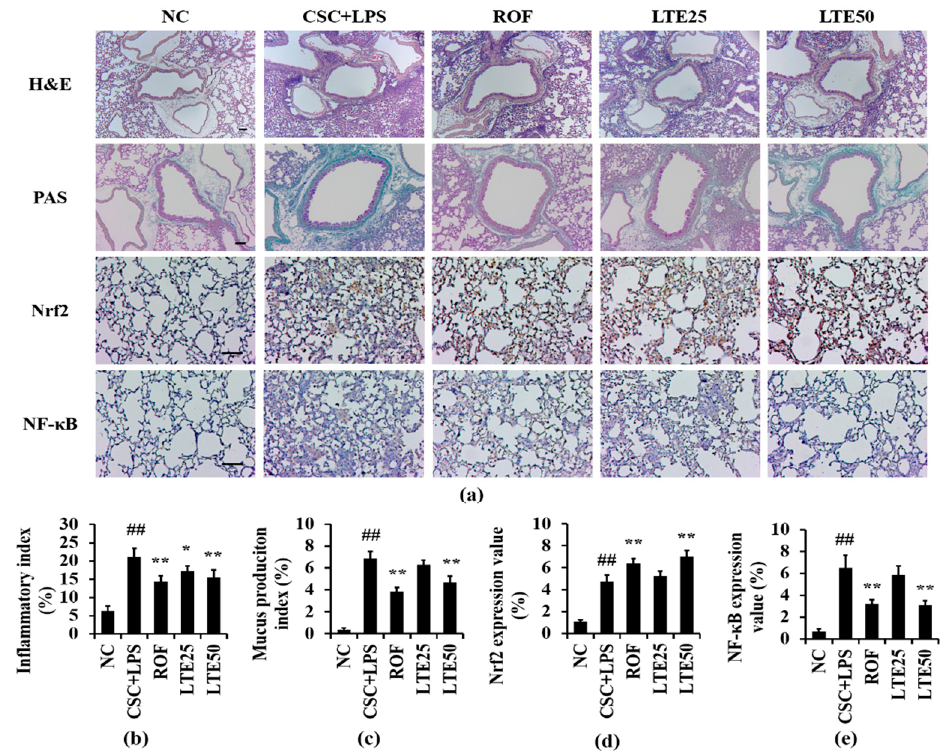
Figure 9. Effects of LTE on histological alteration in CSC+LPS exposed mice. ( a ) representative figure for H&E, PAS and ICH. ( b ) inflammatory index, ( c ) mucus production index, ( d ) Nrf2 expression value, ( e ) NF- κ B expression value. Pulmonary inflammation and mucus production of lung tissue were determined using hematoxylin and eosin and PAS staining, respectively. The expression of Nrf2 and NF- κ B on lung tissue was determined using immunohistochemistry. Scale bar = 100 μ m. ## , vs. NC, p < 0.01, *, **, vs. CSC+LPS, p < 0.05 and <0.01, respectively.